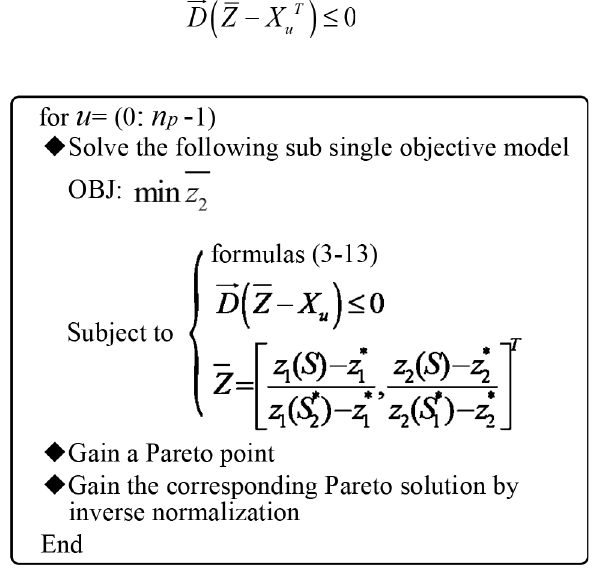
Figure 2. Generation of the Pareto